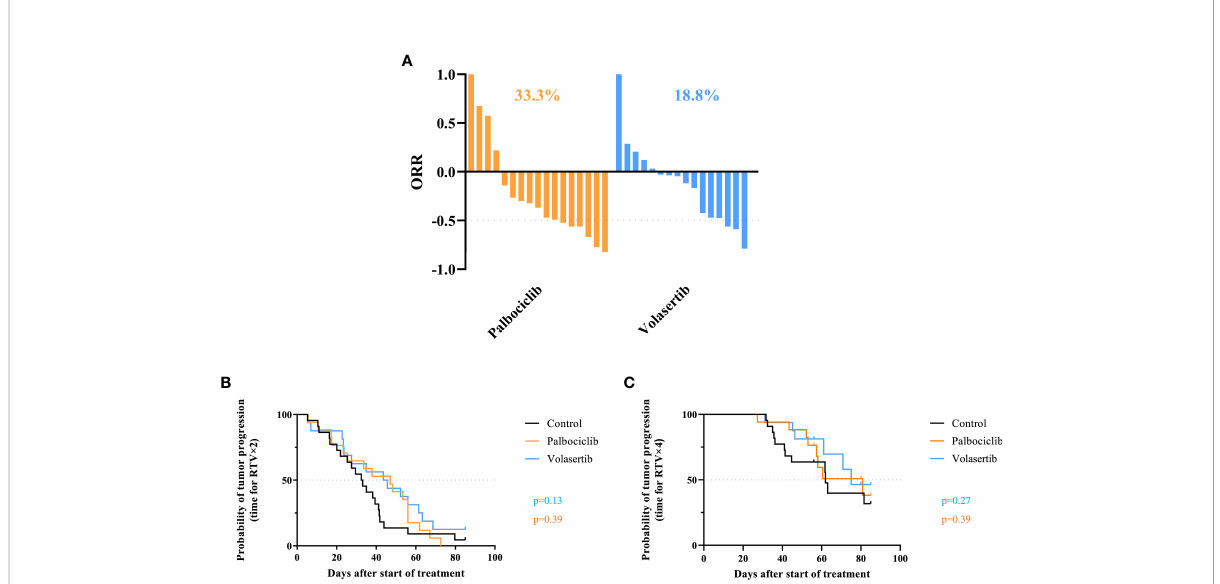
FIGURE 3 Individual tumor responses in the three treated models. (A) Overall response rate (ORR) in all treated chordoma PDXs after palbociclib (n = 17) and volasertib (n = 16). A tumor was considered to be responding to treatment if ORR was below -0.5. (B, C) Probability of progression (RTV × 2 and RTV × 4) in all treated chordoma PDXs after palbociclib and volasertib